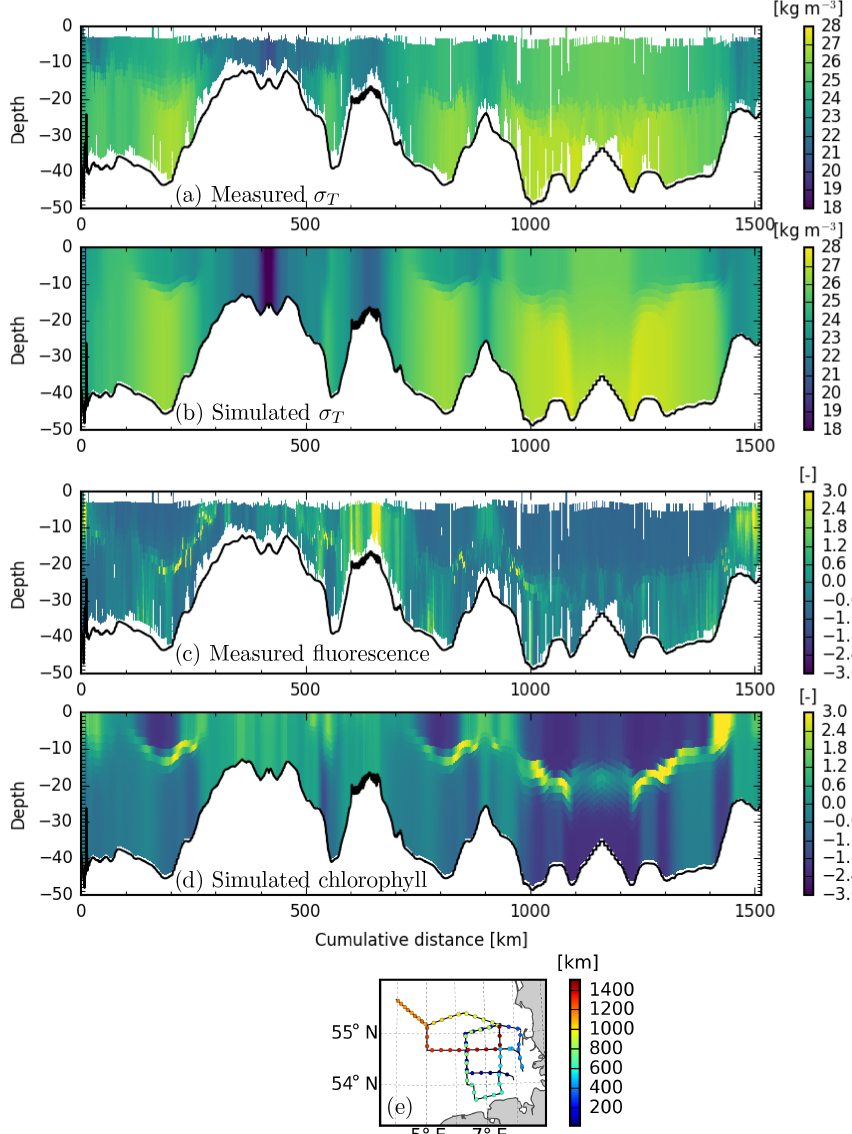
Figure 9. (a, b) σ T measured by Scanfish and estimated by the model; (c, d) normalized anomalies of fluorescence measured by Scanfish and chlorophyll concentrations estimated by the model. The track of the cruise, which took place between 13 and 19 July 2010, is shown in (e)